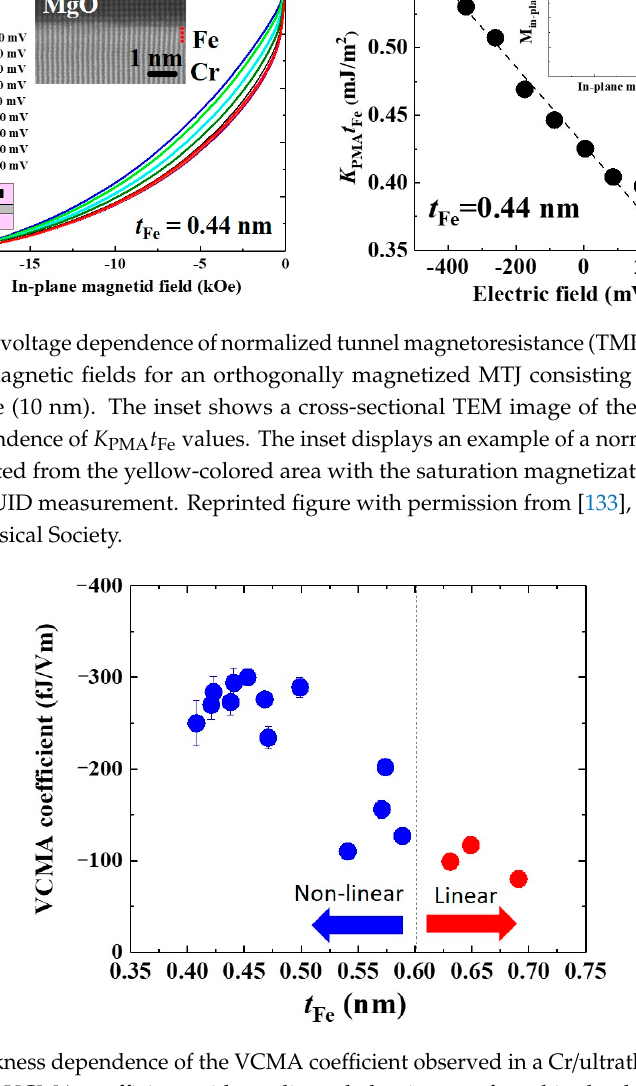
Figure 12. Fe thickness dependence of the VCMA coefficient observed in a Cr/ultrathin Fe( t Fe )/MgO/Fe structure. A large VCMA coefficient with nonlinear behavior was found in the thinner Fe thickness range, t Fe < 0.6 nm (blue dots). Reprinted figure with permission from [133], Copyright by the American Physical Society.